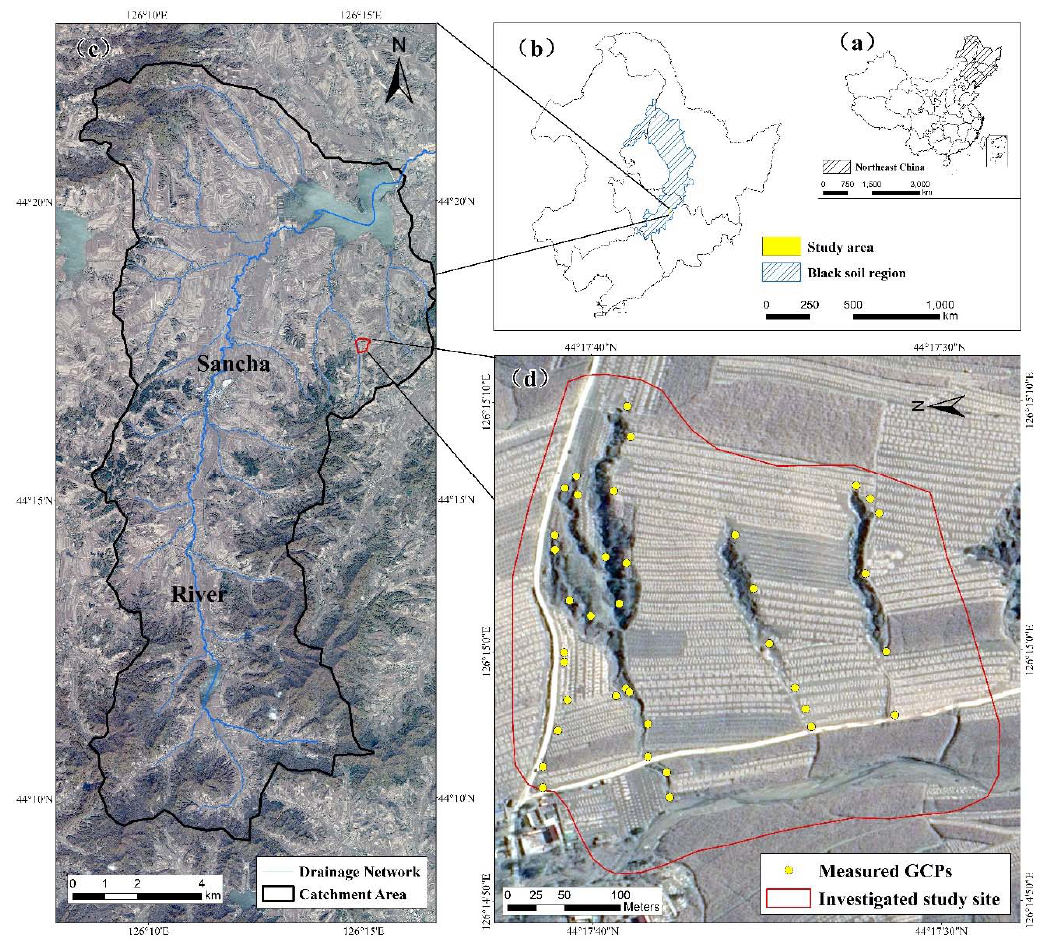
Figure 1. Location of the study area: ( a ) map of Northeast China; ( b ) map of the study area, situated at the southeastern edge of the black soil region; ( c ) overview of the study area with a detailed view of the survey site—the detailed RGB ‐ 321 Pleiades ‐ 1A satellite image includes the Sancha River catchment (12 October 2013); and ( d ) the investigated site was used for detailed mapping and the Ground Control Points (GCPs) were distributed over the site.